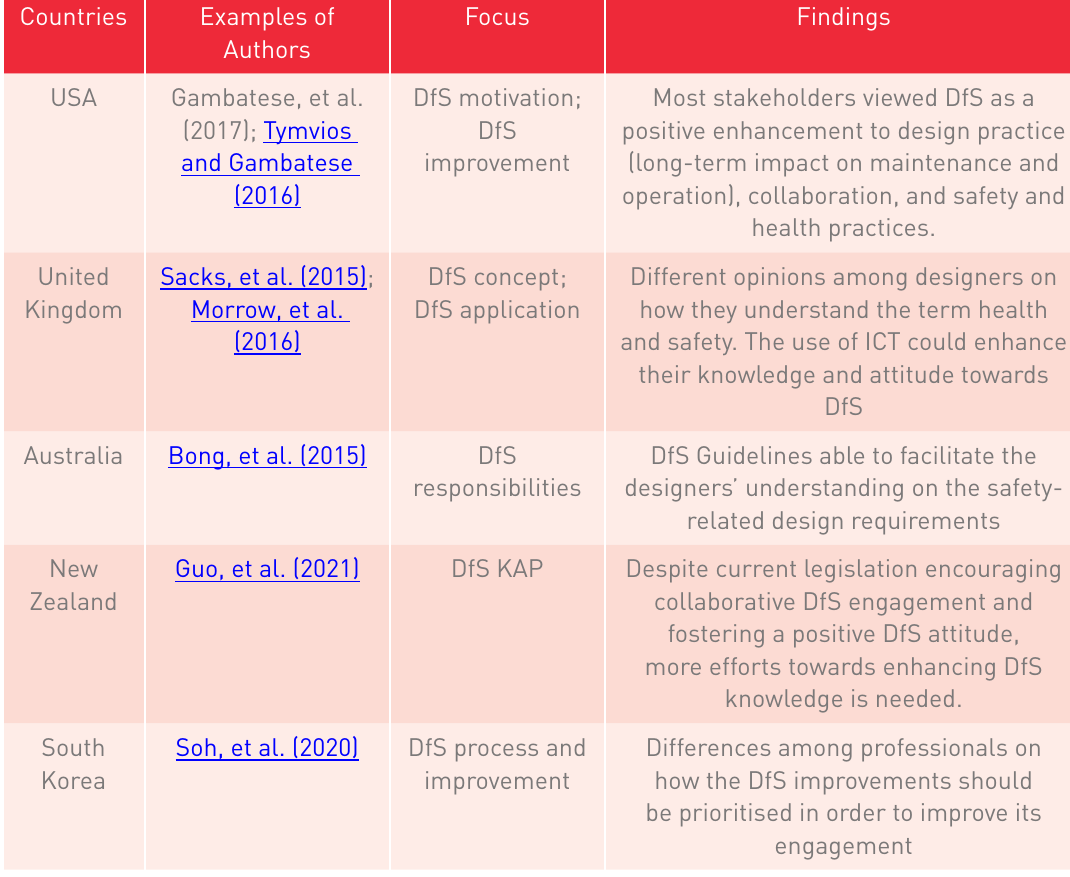
The example of DfS studies (from 2015 onwards) in the construction